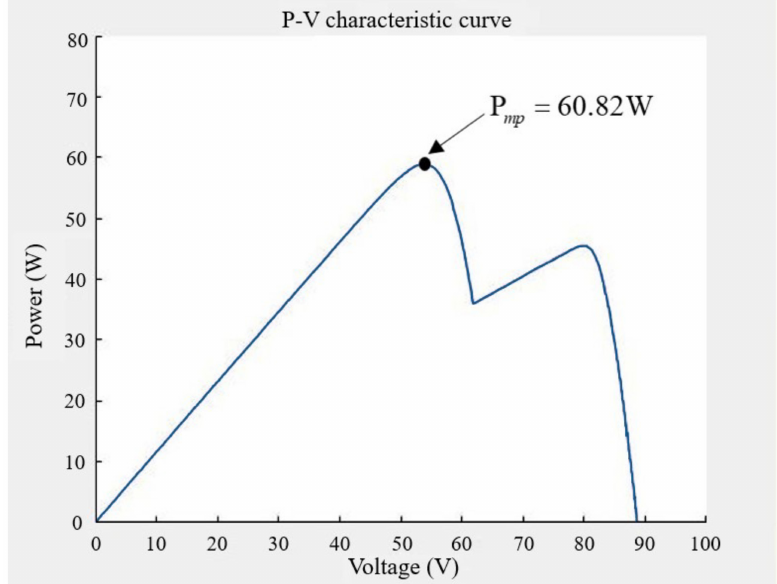
Figure 6. P–V characteristic curve simulation for Case 2.